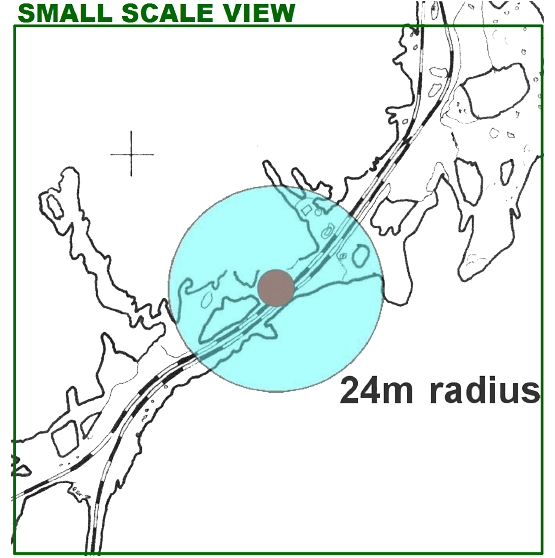
Fig. 13. Estimated radius of good-quality connection for second repetition along the main path of the